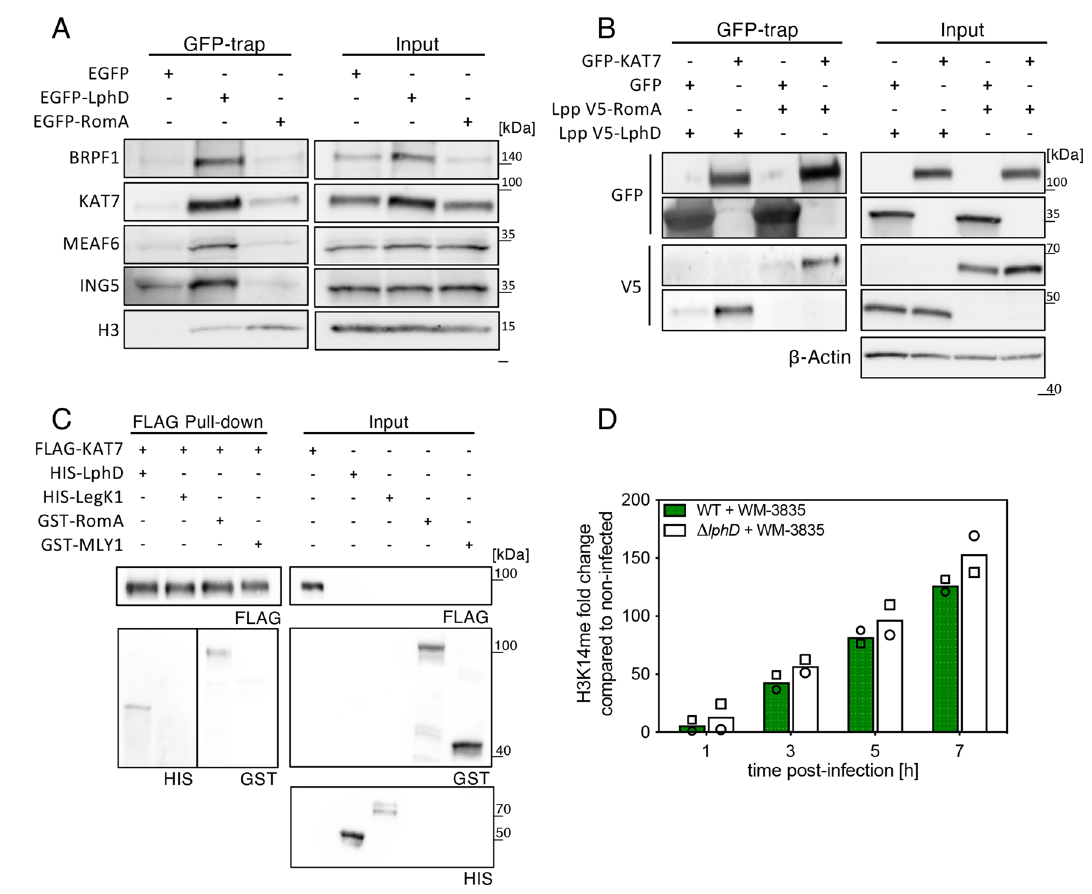
Fig. 6 | LphD and RomA target chromatin via the HBO1/KAT7 complex. A ImmunoblotsshowingtheinteractionofLphDandRomAwiththeHBO1complex and histone H3. GFP-trap in HEK293T cells transfected with EGFP, EGFP-LphD, or EGFP-RomA. Samples were analyzed for the presence of the different components oftheHBO1complex(BRPF1,KAT7,MEAF6,ING5).Inputshowstheexpressionlevel ofendogenousHBO1componentsandhistoneH3intotallysates.ForIPcontrolsee Figure S5F. Representative of n =3 independent experiments. B Immunoblots showing the interaction of LphD and RomA with KAT7. GFP-trap in HEK293-Fc γ RII cells transfected with either EGFP or EGFP-KAT7 followed by infection with L. pneumophila ( Lp )wild-type(wt)over-expressingeitherV5-LphDorV5-RomA.EGFP proteinswerepulleddownusingGFP-trapbeadsandsampleswereanalyzedforthe presence of V5-LphD or V5-RomA. Input shows the expression level in total lysates